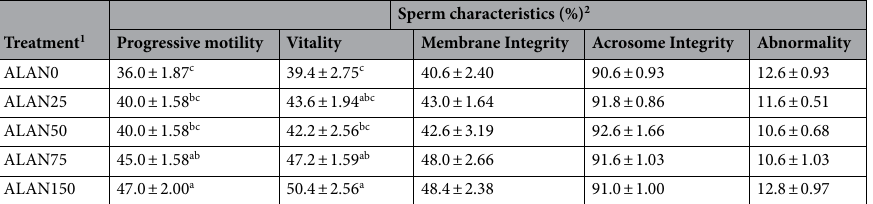
Table 3. Effect of supplementing Tris-extender with alpha-lipoic acid loaded liposomes (ALAN) on sperm characteristics (%) in post-thawed buffalo bull semen (at 37 °C for 30 s). 1 Tris extender supplemented with different levels of alpha-lipoic acid loaded liposomes (ALAN) containing 0 (ALAN0), 25 (ALAN25), 50 (ALAN50), 75 ALAN75 and 150 ALAN150 (0, 25, 50, 75 and 150 µg/mL), respectively. 2 a–c means denoted within the same column with different superscripts are significantly different at P < 0.05.